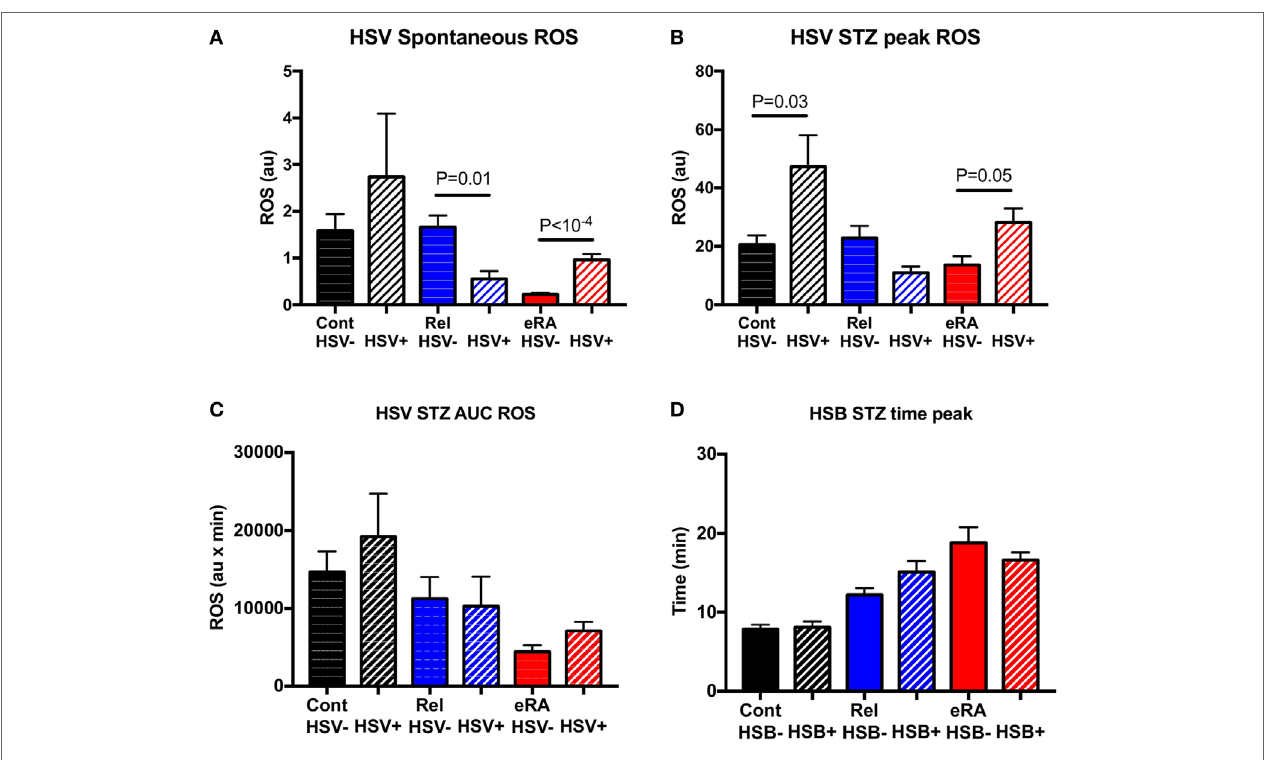
FigUre 4 | Impact of a history of herpes simplex virus (HSV) exacerbation/reactivation in the year preceding sample collection in granulocyte reactive oxygen species (ROS) production: spontaneous (a) , after serum-treated zymozan (STZ) stimulation at peak (b) , area under the curve (AUC) (c) , and time to reach peak ROS production (D) . Healthy controls (Cont), rheumatoid arthritis (RA) first-degree relatives (Rel), and untreated RA patients at onset (early RA). Statistics are indicated when P ≤